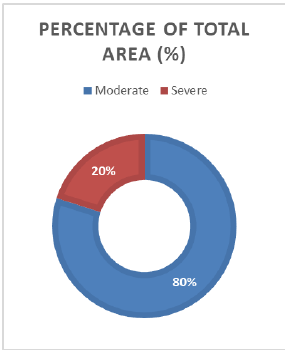
Figure 5. Proportion of dry area of each type based on the percentage of precipitation anomaly in March 2016 in Donglei Irrigation District (Phase Ⅱ